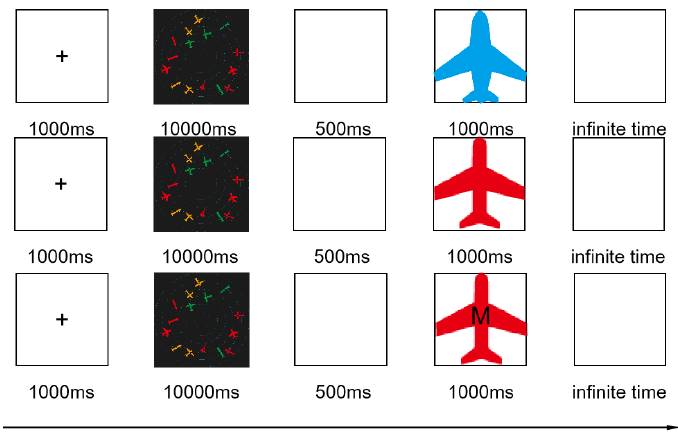
Figure 2. Information pressure experimental